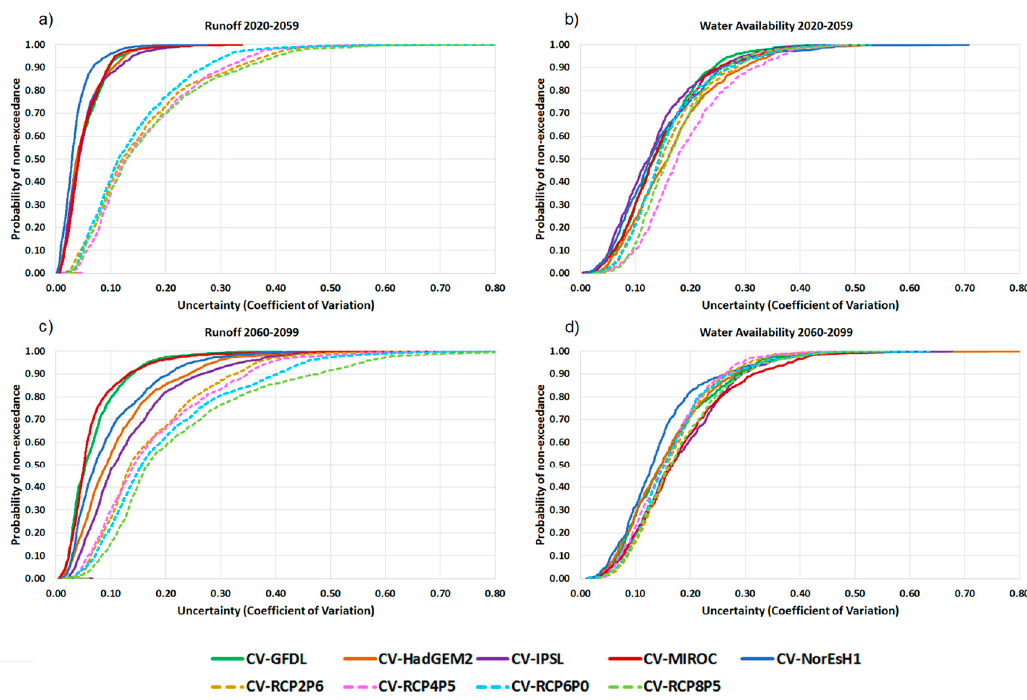
Figure 9. Climate model and emissions scenario uncertainties. Each continuous line represents the probability distribution function (Pdf) of the coefficient of variation (CV) corresponding to mean annual runoff and mean annual water availability in each calculation point, for each climate model (GFDL, green; HadGEM2, brown; IPSL, purple; MIROC, red; and NorEsH1, blue) and four emissions scenarios (RCP2.6, RCP4.5, RCP6.0, and RCP 8.5). Dashed line represents the Pdf of CV for each emissions scenario and the five climate models. ( a ) Runoff and short-term period (ST) and ( c ) long-term period (LT); ( b ) Water availability and ST and ( d ) LT.